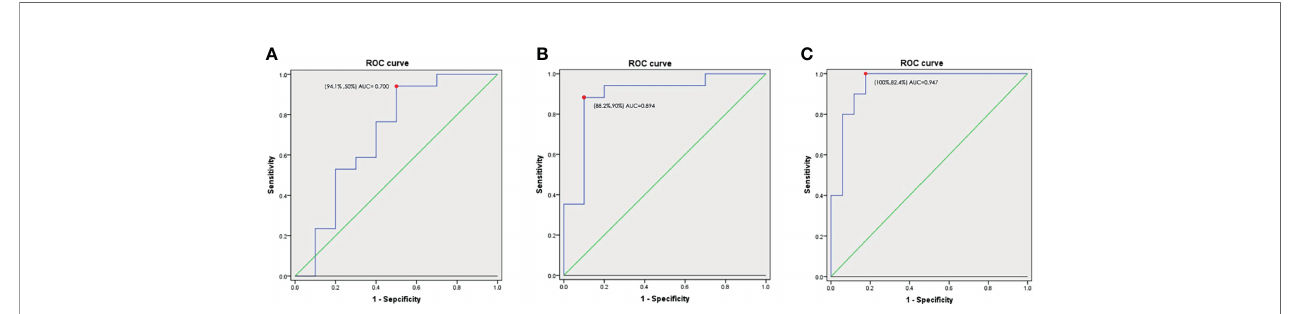
FIGURE 4 | (A). ROC curveand AUC values of hippurate on predicting OSA remission after RYGB surgery; (B) ROC curve and AUCvalues of combined preoperative indices (age, AHI, andfasting C-peptide level) onpredictingOSA remission after RYGB surgery; (C) ROC curve and AUCvalues ofcombined preoperativeindices (age, AHI, andfasting C-peptide and hippurate levels) onpredicting OSA remission after RYGB surgery. Abbreviations: ROC, receiver operating characteristic; AUC, area under the curve; AHI, apnea –